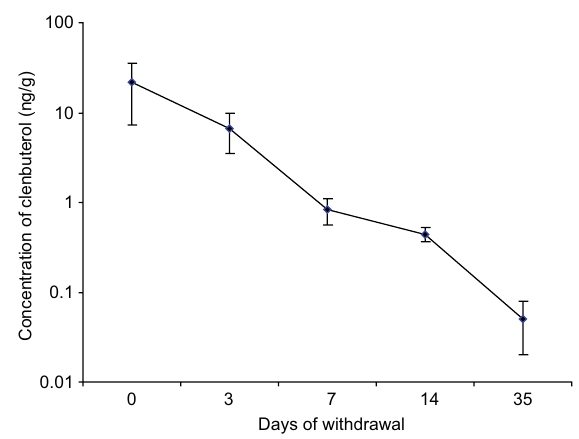
Figure 2 Mean ( ± SD) clenbuterol concentration (ng/g) in pig a liver determined by validated LC-ESI/MS/MS method on days during the withdrawal period. a Male pigs (n = 15) known bred aged 90 days, body mass 50